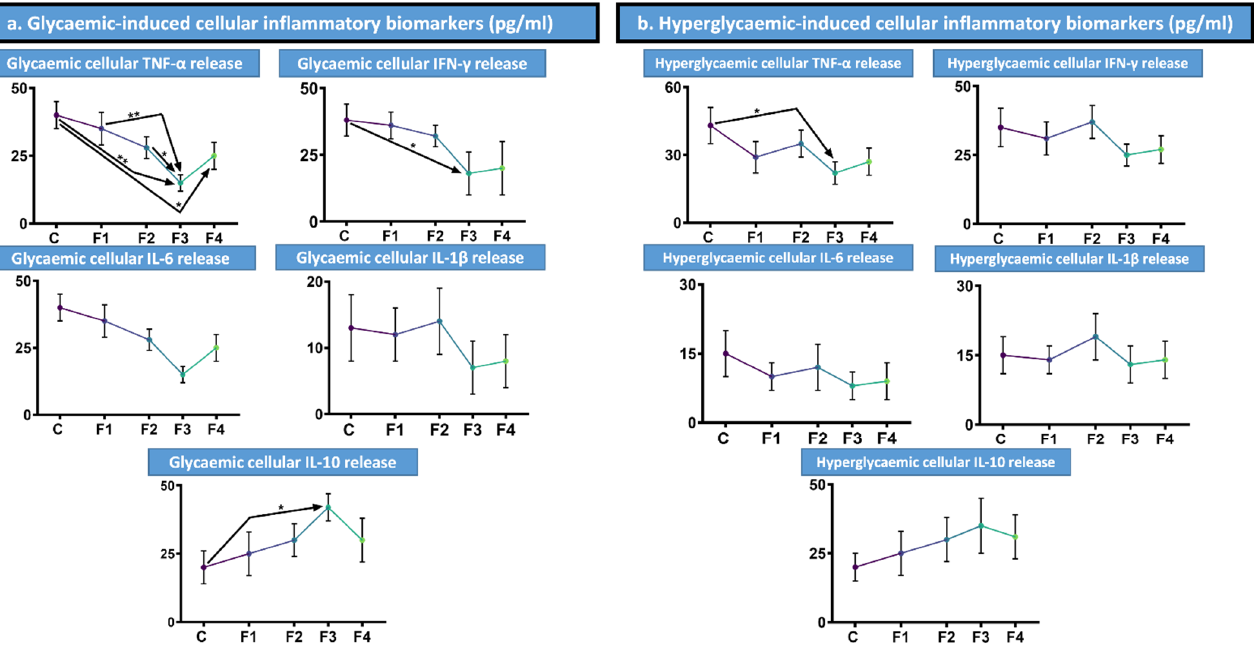
Figure 3. Cytokine biomarker detection in glycaemic and hyperglycaemic conditions. ( a ). Glycae- mic-induced pro-inflammatory biomarker release TNF- α , IFN- γ , IL-6, and IL-1 β ; and anti-inflammatory IL-10 (pg/mL). ( b ). Hyperglycaemic-induced pro-inflammatory biomarker release TNF- α , IFN- γ , IL-6, and IL-1 β ; and anti-inflammatory IL-10 (pg/mL). Assessed on formulations 1 to 4 with the control being unencapsulated MIN6 pancreatic β -cells (C). Presented as Mean ± SEM, with arrows used to denote any statistical significance between data points. * p < 0.05, ** p < 0.01.